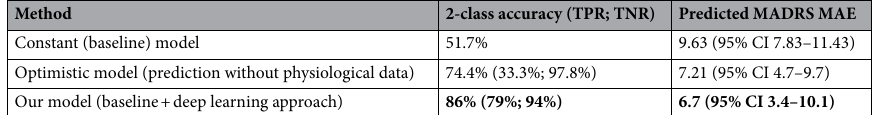
Table 3. Comparison between our model and two baselines. Perturbation study of our model. The 2-classes test accuracy was computed for the discrimination between ‘ill’ and ‘healthy’ classes. The true positive rate (TPR) and true negative rate (TNR) are also reported. The predicted MADRS MAE refers to the mean absolute error (95% confidence interval) in MADRS scores estimated by the model on the test set. The best results are reported in bold font and correspond to our deep learning